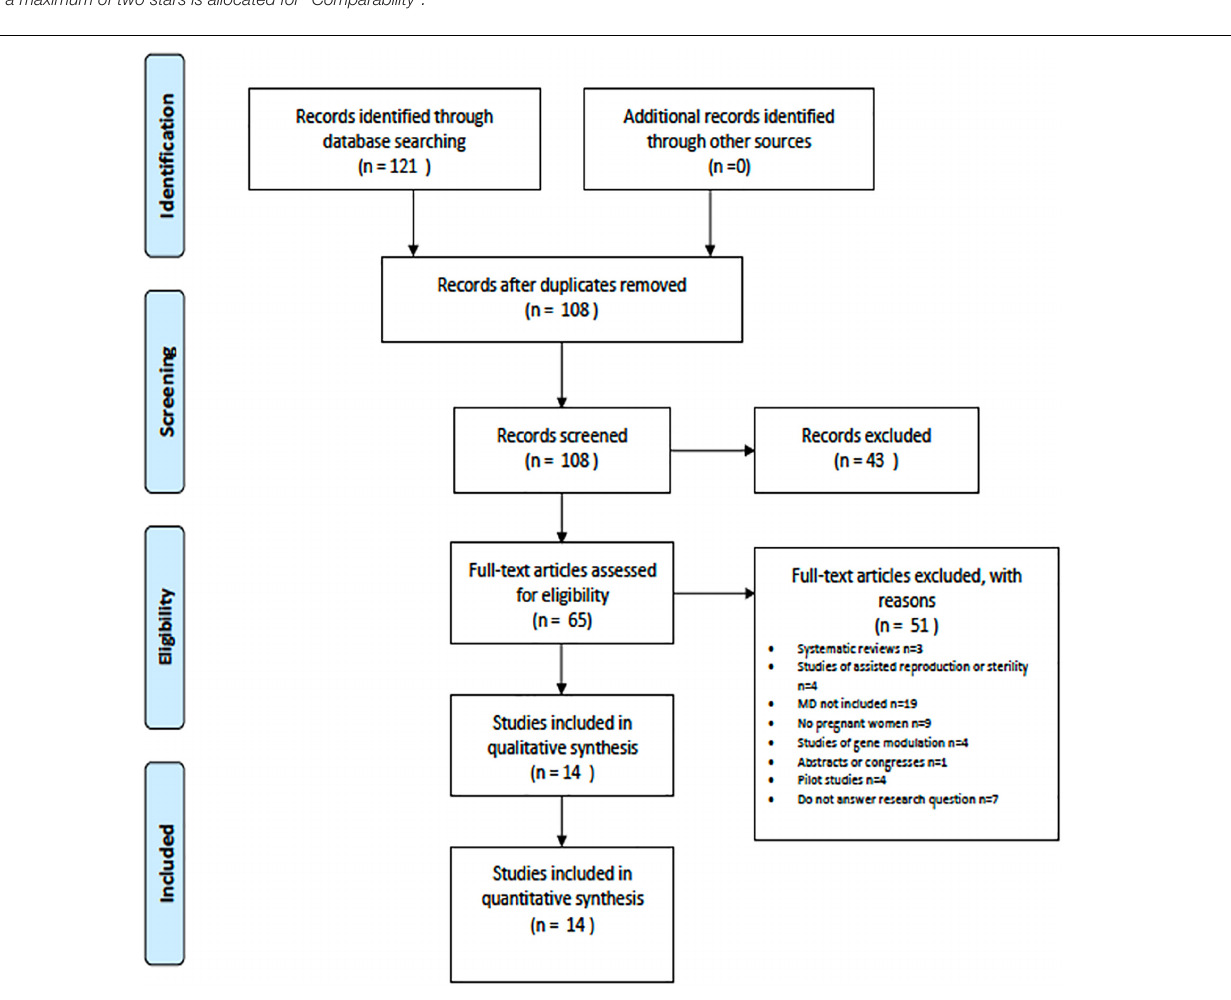
FIGURE 1 | Selection of